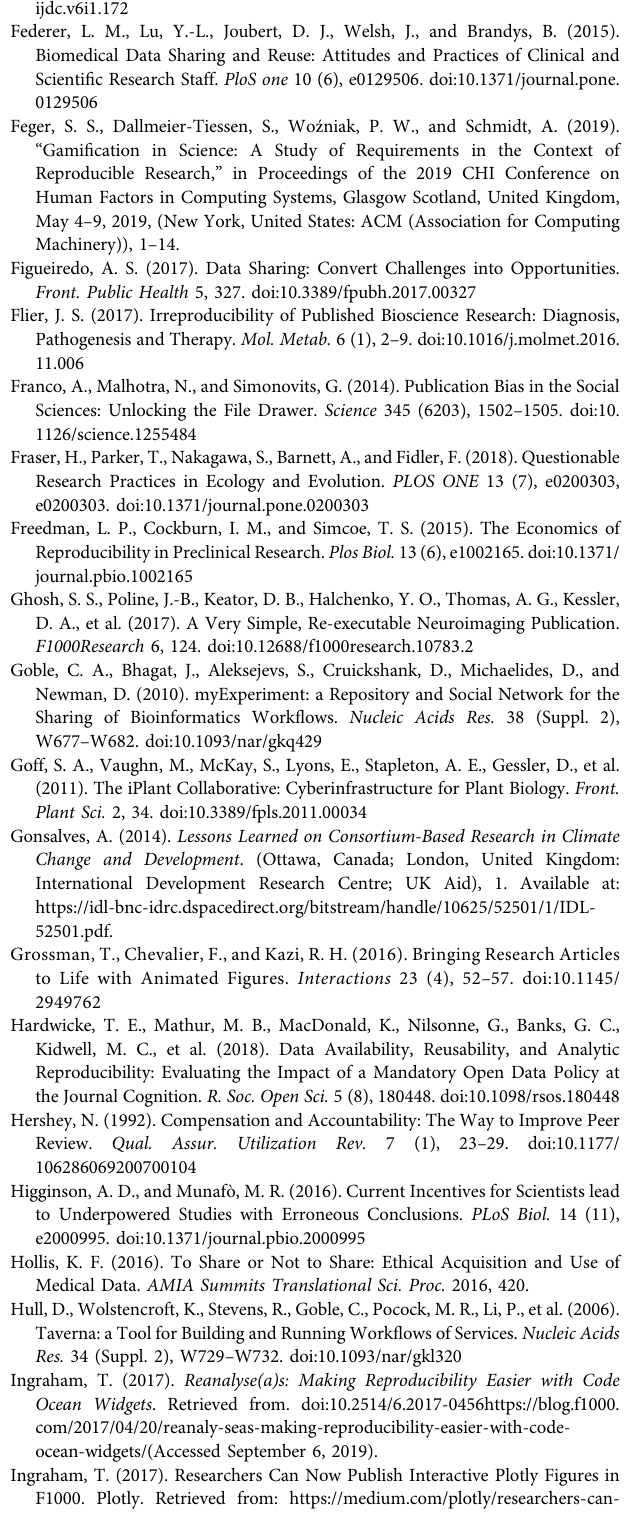
Figueiredo, A. S. (2017). Data Sharing: Convert Challenges into Opportunities. Front. Public Health 5, 327.